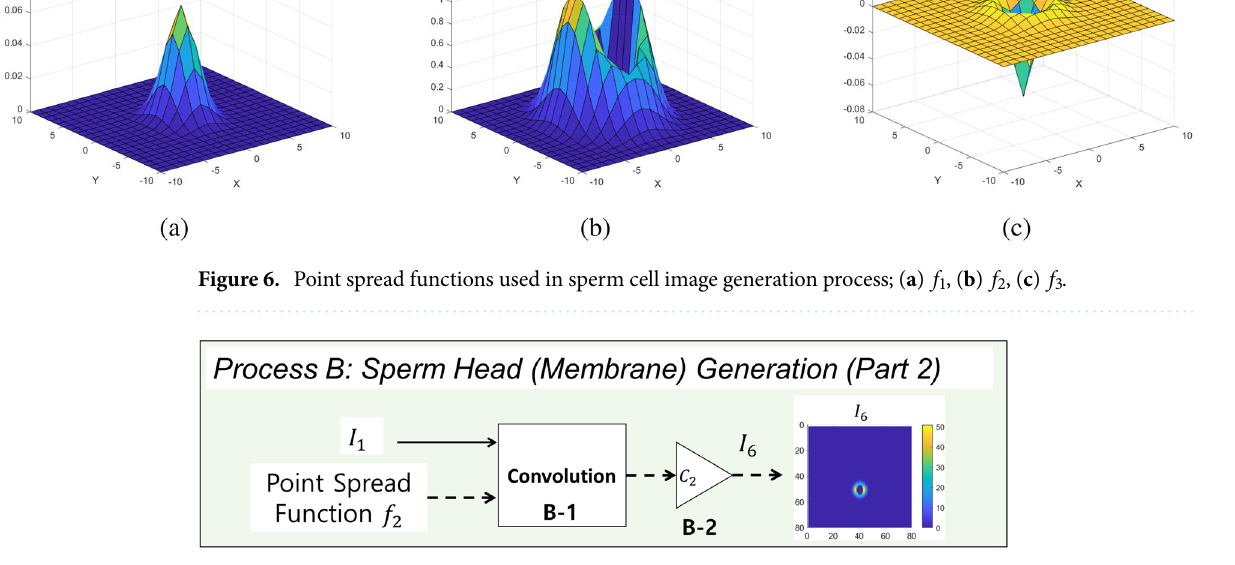
Figure 7. Flowchart of the image generation process of the sperm membrane. Image I 1 and point spread function f 2 are the inputs. The output is the simulated image of sperm membrane I 6 . I 1 and f 1 is convolved and then scaled by C 1 to generate I 6 (Processes B-1 and B-2).